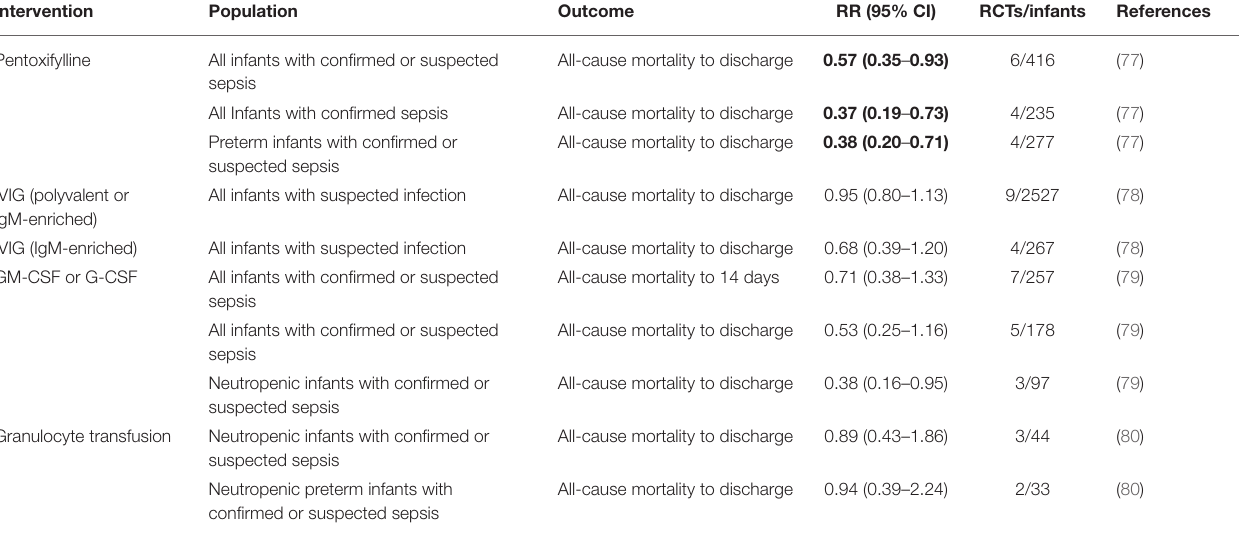
TABLE 1 | Meta-analyses on adjunctive therapy for neonatal sepsis.